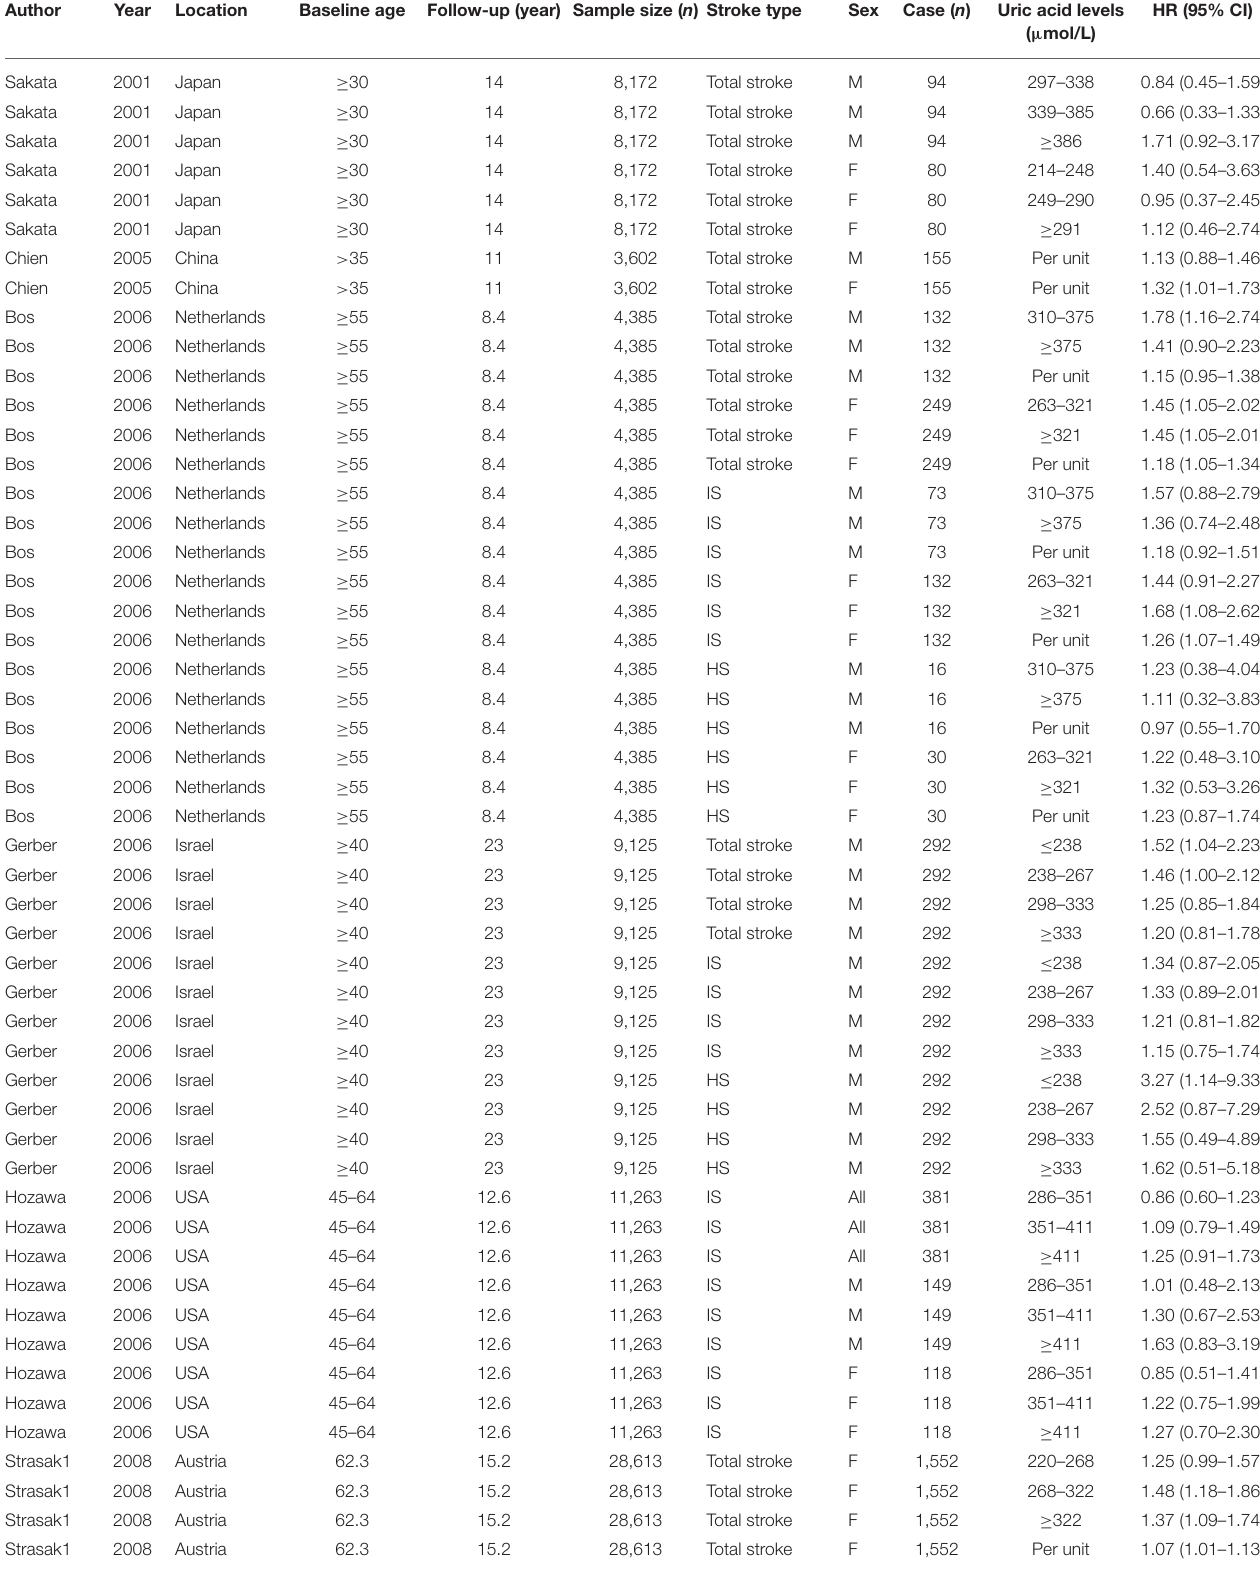
TABLE 1 | Baseline characters of the associations between UA levels and the risk of having